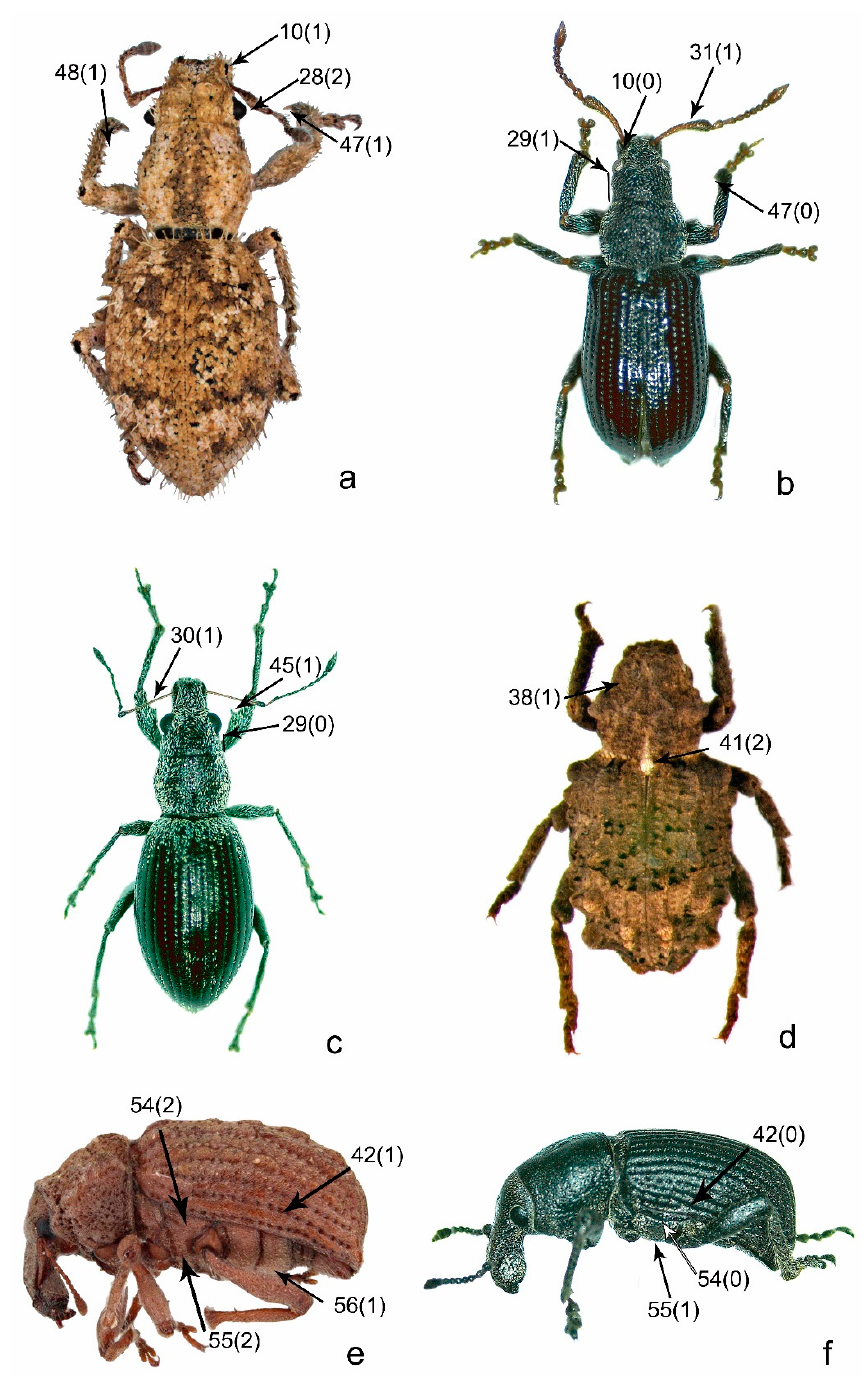
Figure 3. Morphology of adults, habitus: ( a ) Symmathetes setulosus , dorsal view; ( b ) Phyllobius viridicollis , dorsal view; ( c ) Eusomus ovulum , dorsal view; ( d ) Rhigopsidius piercei , dorsal view; ( e ) Premnotrypes latithorax , lateral view; and ( f ) Strangaliodes niger , lateral view. Arrows indicate characters and character states (between parentheses).